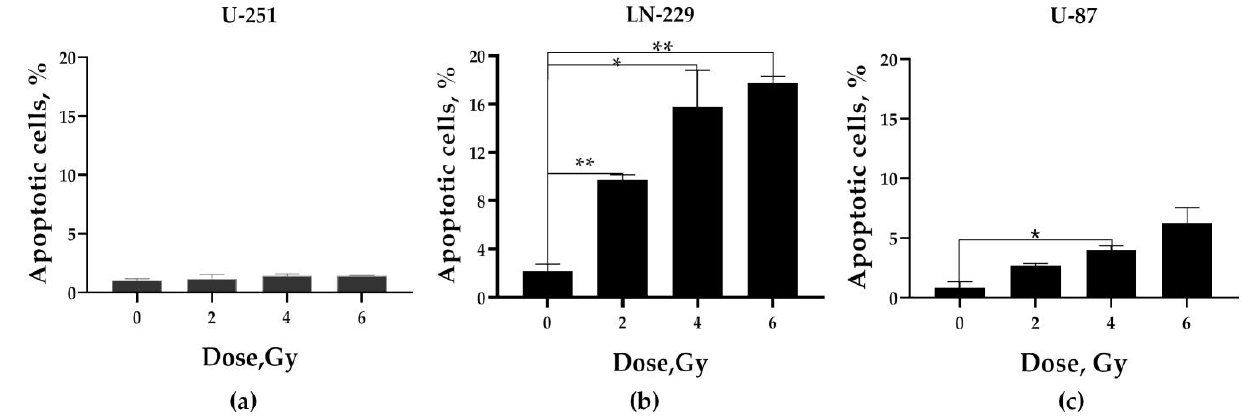
Figure 6. Assessment of apoptosis by YO-PRO-1 in GBM cell lines. Percentages of apoptotic U-251 ( a ), LN-229 ( b ), and U-87 ( c ) cells demonstrate highest rate of apoptosis (YO-PRO-1 positive) in LN-229 cells compared to parental cells 24 h after exposure to IR. Data are means ± SE. * p ≤ 0.05, ** p ≤ 0.01 .